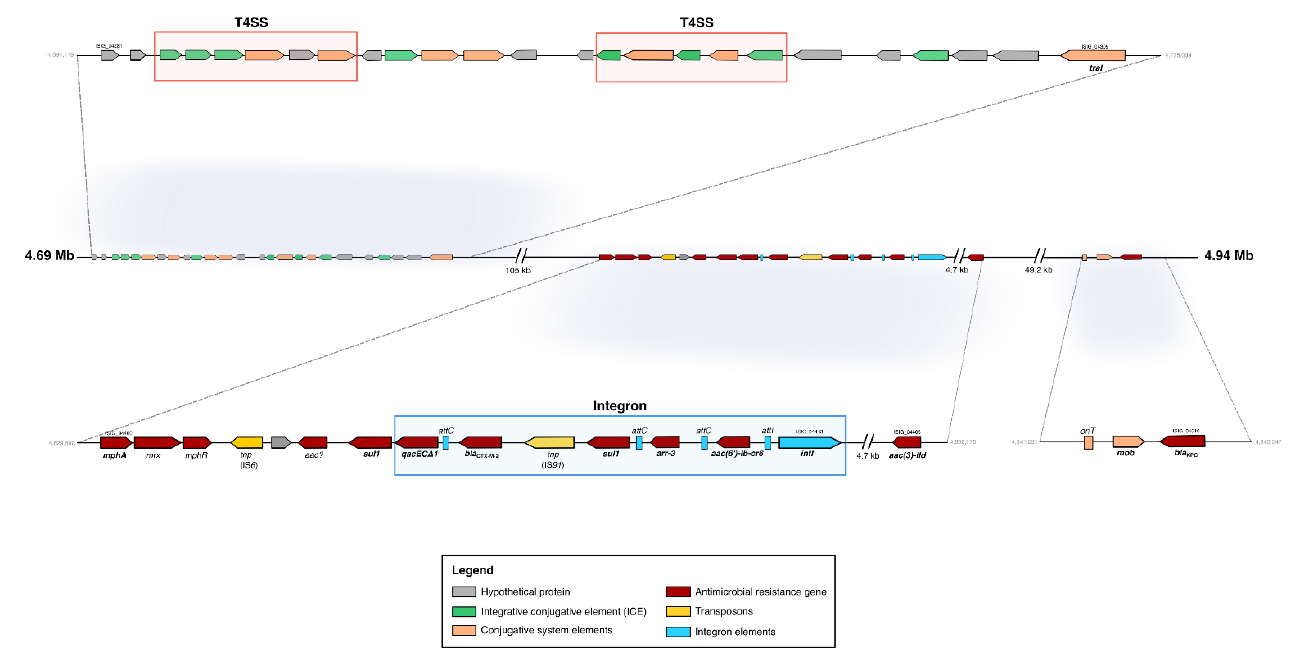
Figure 3. A highly mobilizable region in A. hydrophila 34SFC-3 genome. All genes are represented by arrows which indicate their genomic orientation. Genes encoding the respective mobile elements and ARGs are differently colored following the legend. Three key areas are zoomed in for greater comprehension of the genetic contexts surrounding ARGs and mobile elements.